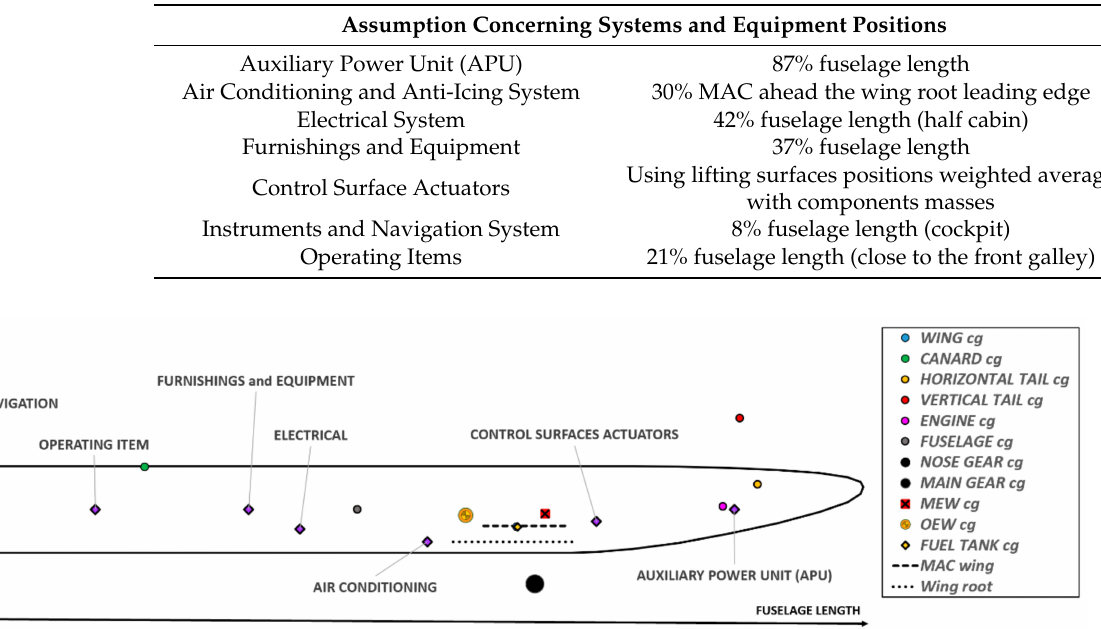
Table 3. On-board systems assumptions for the MDA cycle of each aircraft configuration.